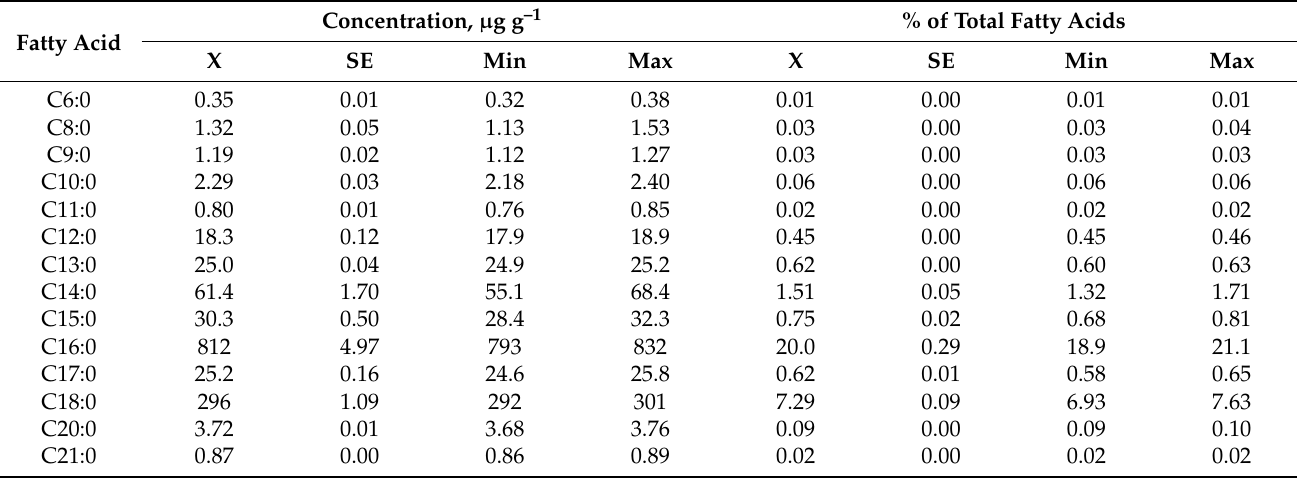
Table 2. Fatty acid composition in the flesh of northern pike from the Gyda